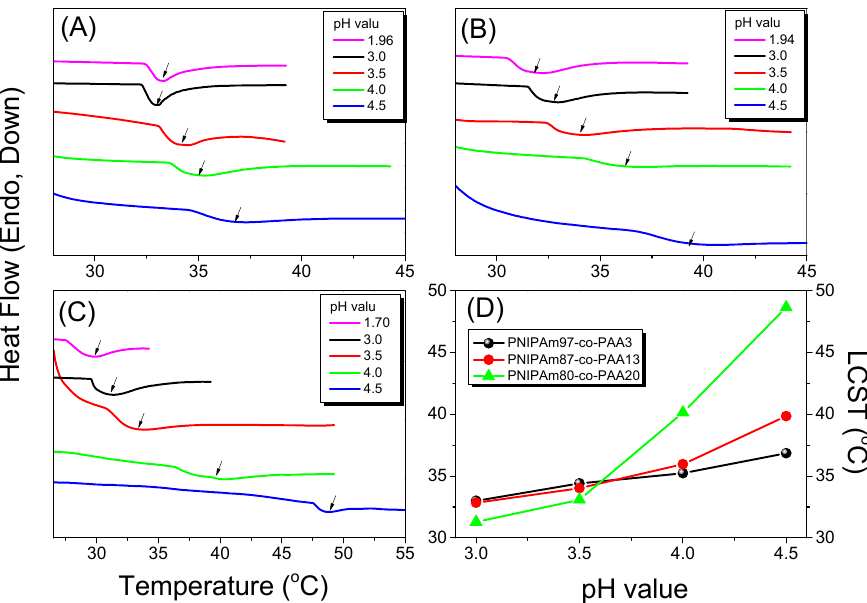
Figure 7. ( A – C ) DSC thermograms of aqueous solutions at various values of pH for: ( A ) PNIPAAm97- co -PAA3; ( B ) PNIPAAm87- co -PAA13; and ( C ) PNIPAAm80- co -PAA20 random copolymers. ( D ) Corresponding LCSTs of aqueous PNIPAAm- co -PAA solutions at various values of pH.